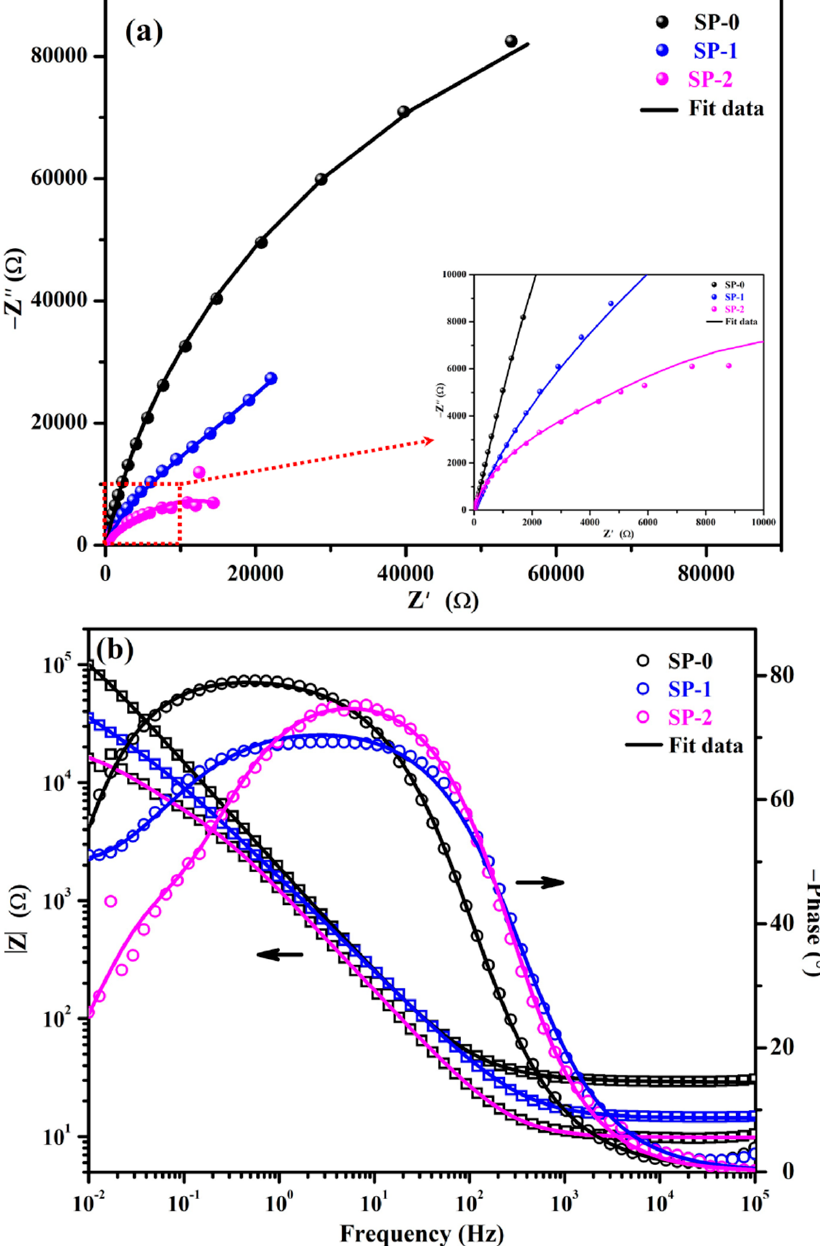
Figure 2. EIS plots for ( a ) Nyquist and ( b ) Bode after 1 h of immersion. The modulus Bode plots of steel rebars after 1 h of immersion are illustrated in Figure 2b. The total impedance of steel rebar immersed in the SP-0 solution measured the highest at 0.01 Hz followed by SP-1 and SP-2. The impedance values of NaCl added solution decreased gradually once the amount increased, suggesting that the formed passive film or adsorbed Zwitterion-Fe complex started to perturb. It is well known that once the chloride concentration increased, the deterioration of passive film increased